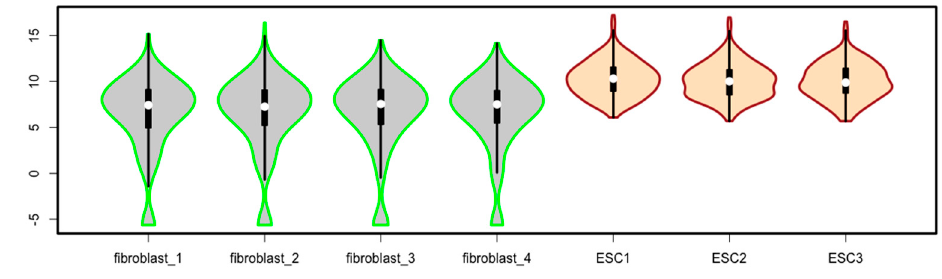
Figure 30. Violin plots generated using the R package of vioplot .